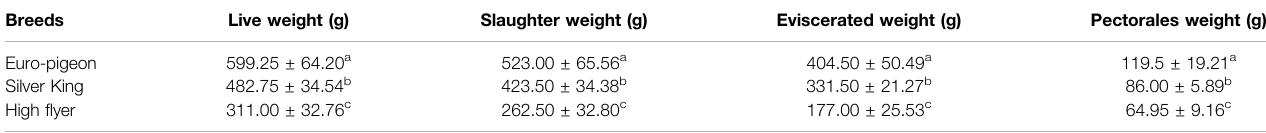
TABLE 1 | Slaughter traits of three pigeon breeds.